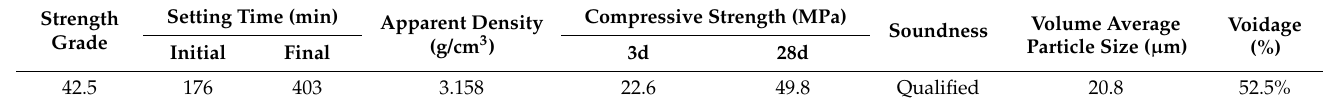
Table 3. Main technical properties of cement.